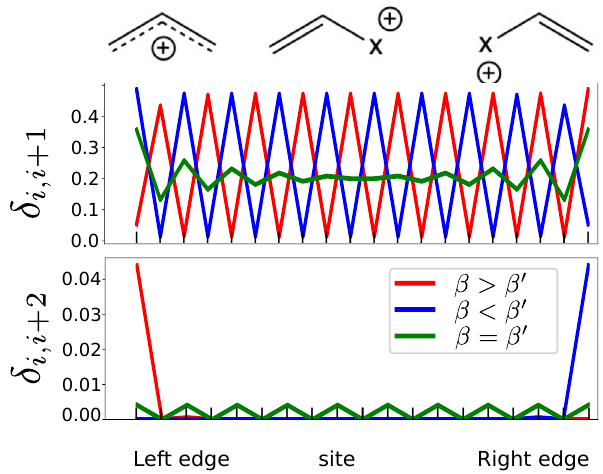
Figure 8. Resonance schemes, δ i , i + 1 and δ i , i + 2 for a chain with N = 21 atoms.